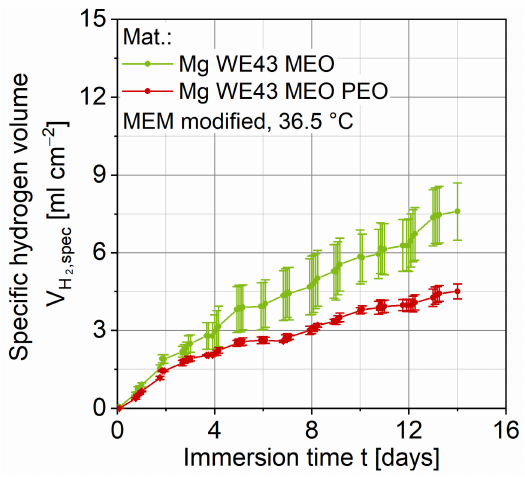
Figure 4. Results of immersion tests on Mg WE43 MEO and WE43 MEO PEO in a modified minimum essential medium at 36.5 ◦ C and an immersion time of up to 14 days.